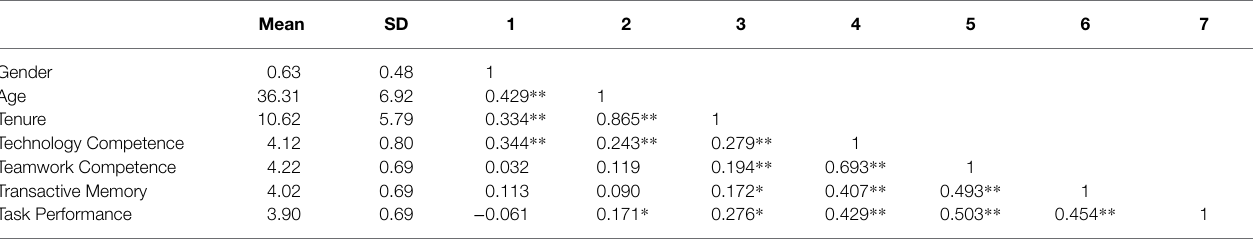
TABLE 1 | Descriptive statistics and correlations.